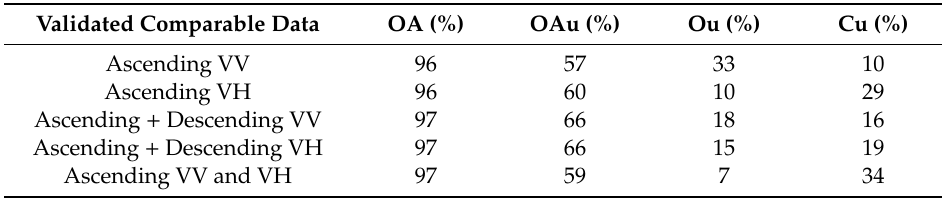
Table 4. Summary of the validation results for the comparison of the MTC derived comparable burnt area delineation and the reference data created using Sentinel-2